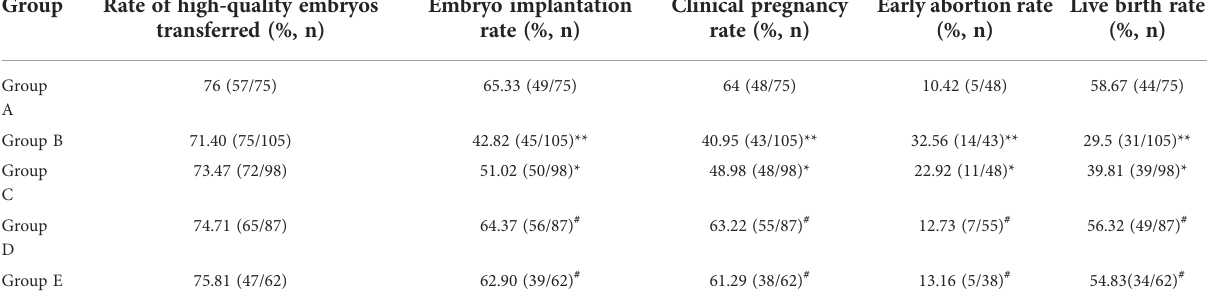
TABLE 7 Pregnancy outcome.